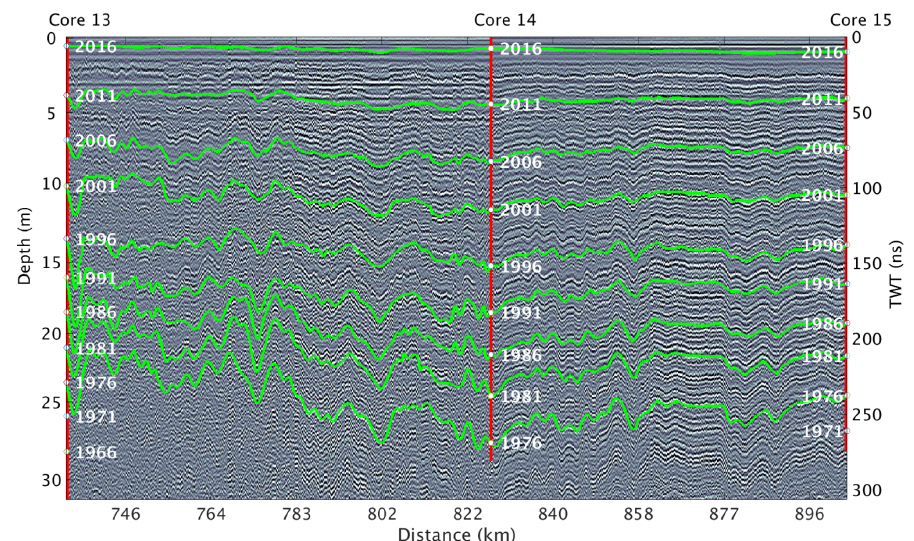
Figure 2. Radargram showing the top 32m of the transect along the main 2017 traverse from Core 13 to Core 15. Cores are indicated as red lines down to their final depth, with dates plotted every 5 years at corresponding depths. Traced internal reflecting horizons are shown as isochronous green lines. The depth scale on the vertical axis is calculated from the two-way travel time-to-depth conversion (see Sect. 2.4) for Core 13, although there is no visual difference in depth scale across this